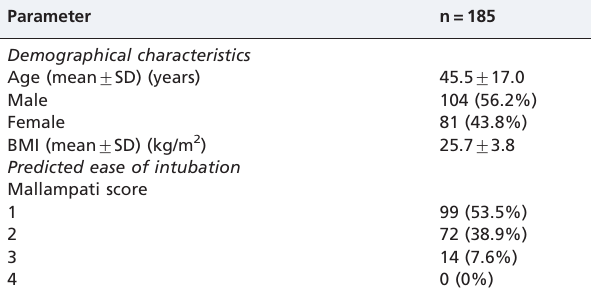
Table 3 - Alteration or no change in the Cormack-Lehane